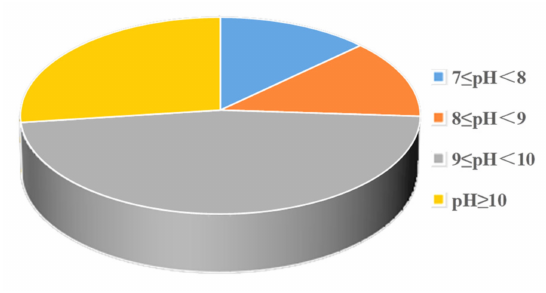
Figure 7. pH value distribution of tunnel groundwater.